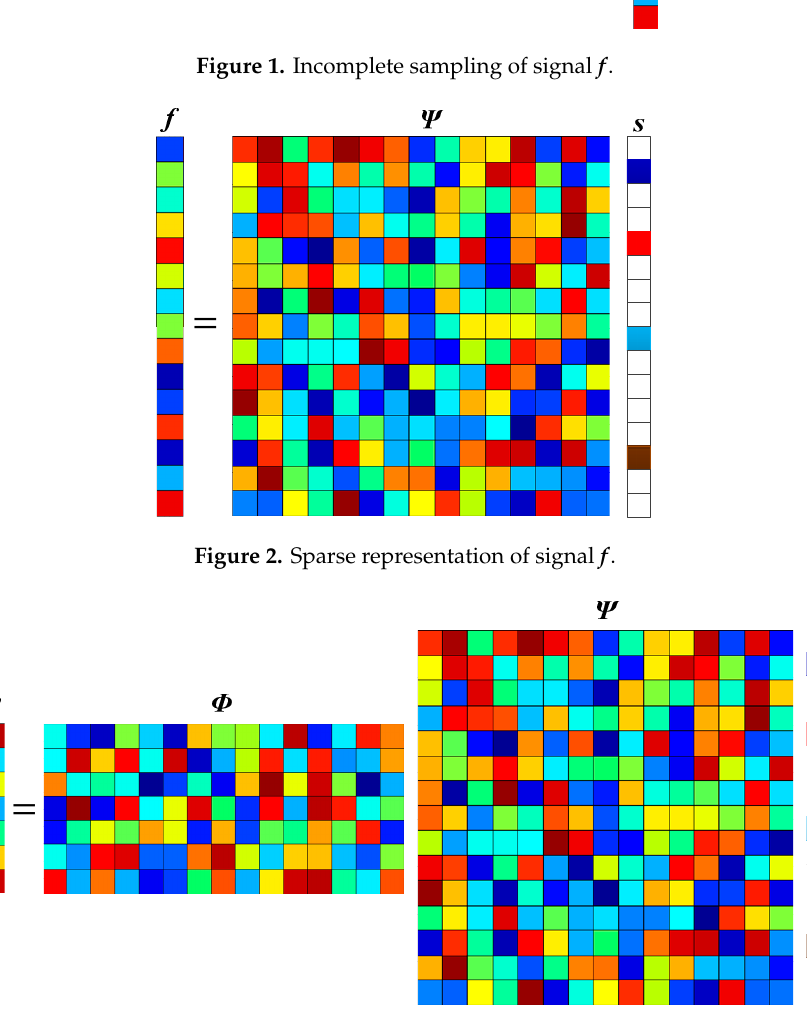
Figure 3. Basic principles of compressed sensing.